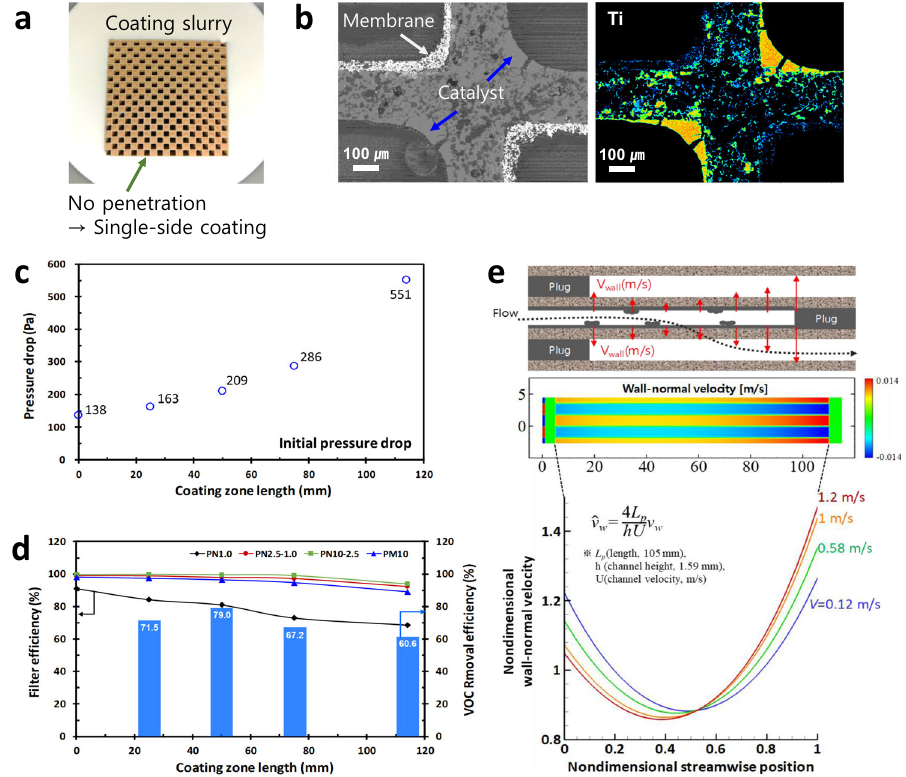
Fig.4|FabricationofCCFanditssimultaneousremovalef fi ciency.a Imageofa single-side slurry coating with no through-wall penetration. b SEM image of CCF fabricated by coating the membrane and catalyst on different surfaces and dis- tributing the main element of the catalyst (Ti) by SEM-EPMA element mapping. c InitialpressuredropsofCCFsalongthecatalystcoatingzonewithlengthsof0to